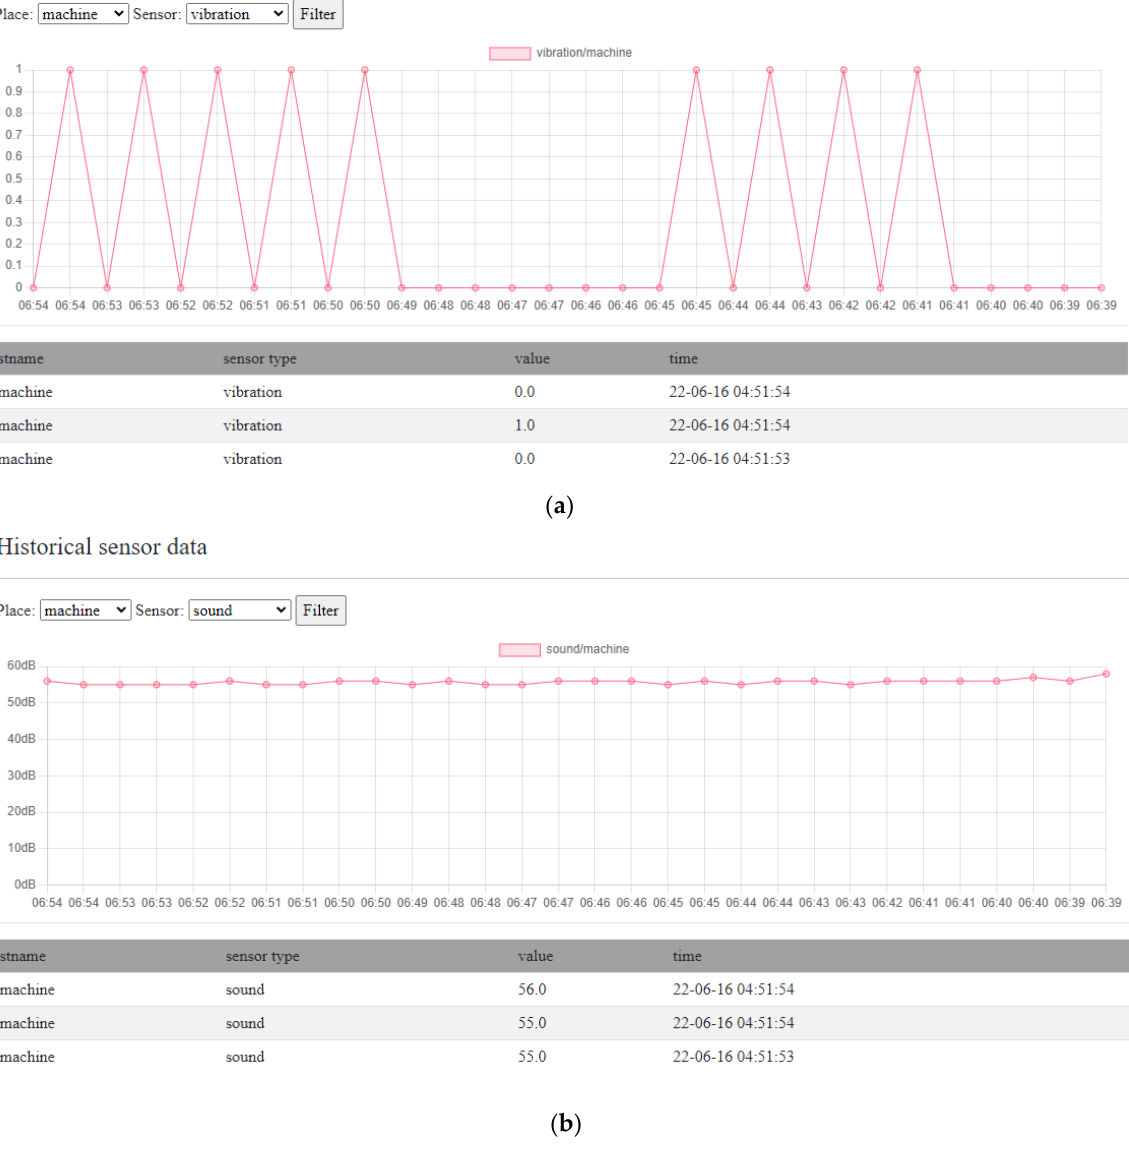
Figure 16. Historical data of measured signal: ( a ) vibration; ( b ) sound.